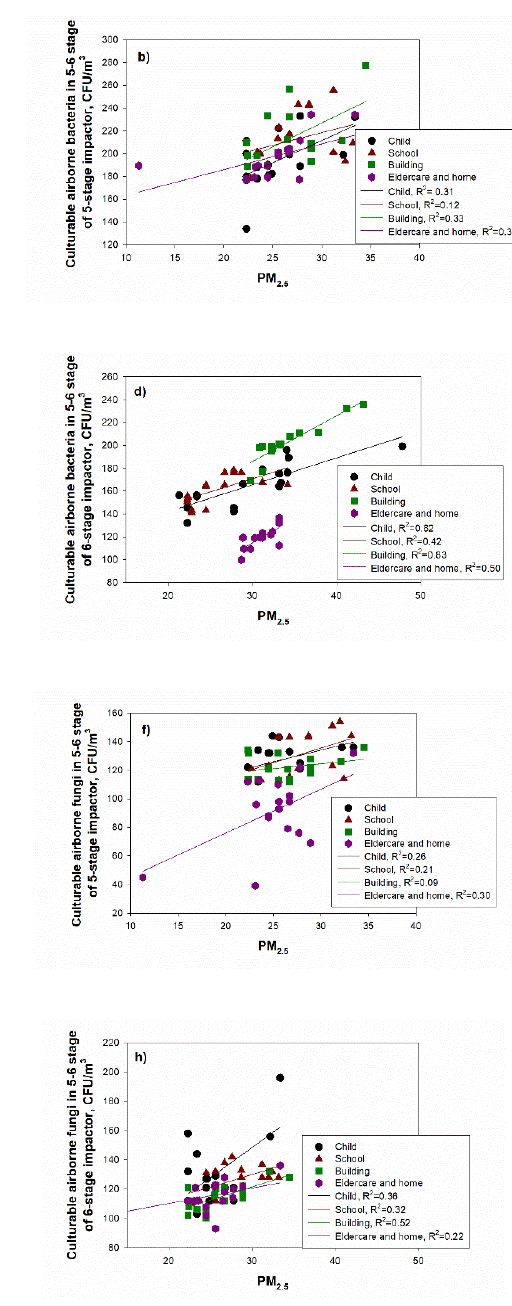
Figure 7. Correlation between PM concentrations and culturable bioaerosol. ( a ), ( b ), ( c ), ( d ): airborne bacteria during spring, summer, autumn and winter, respectively. ( e ), ( f ), ( g ), ( h ): airborne fungi during spring, summer, autumn and winter, respectively.